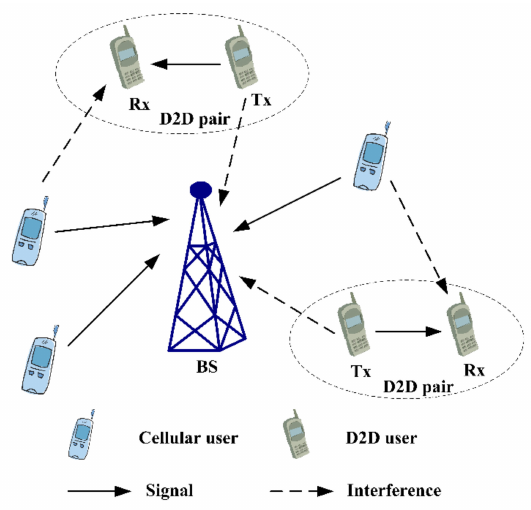
Figure 1. Scenario of D2D communication with uplink RBs’